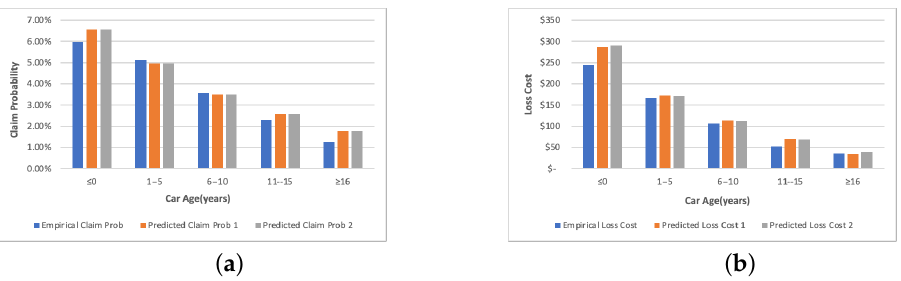
Figure 3. Comparison of empirical and predicted values of claim probability and loss cost by car age groups. ( a ) presents the results of claim probability. ( b ) corresponds to the loss cost. The orange bar shows results for predictions without using clusters. The grey bar presents results for predictions with designed